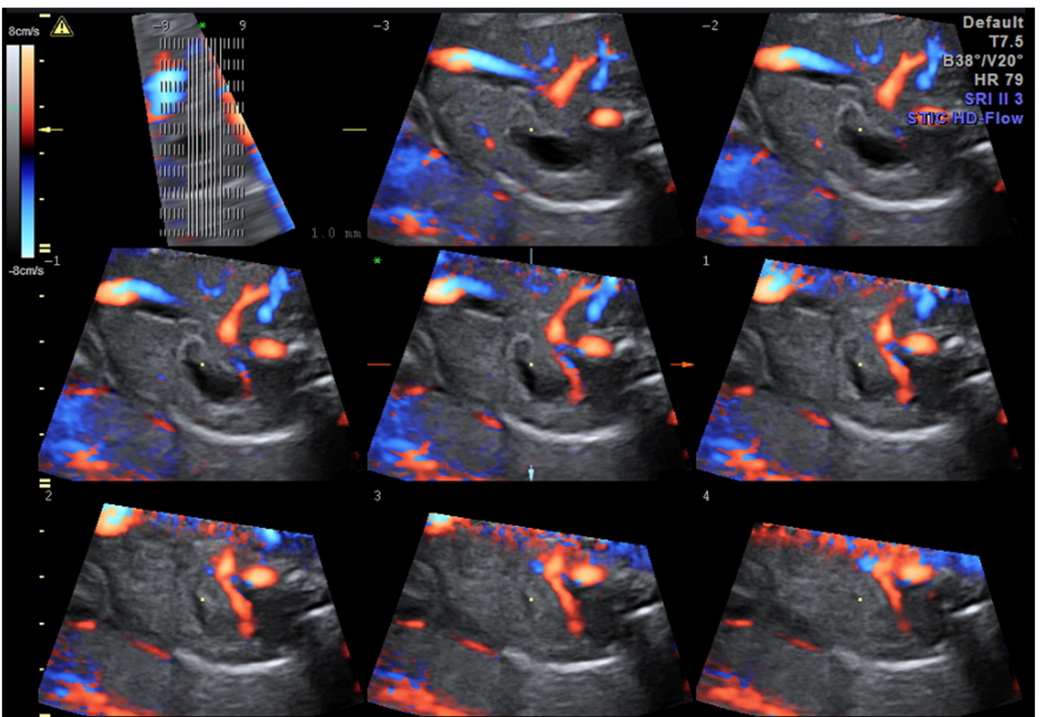
Figure 7. Two-dimensional imaging of a double umbilical